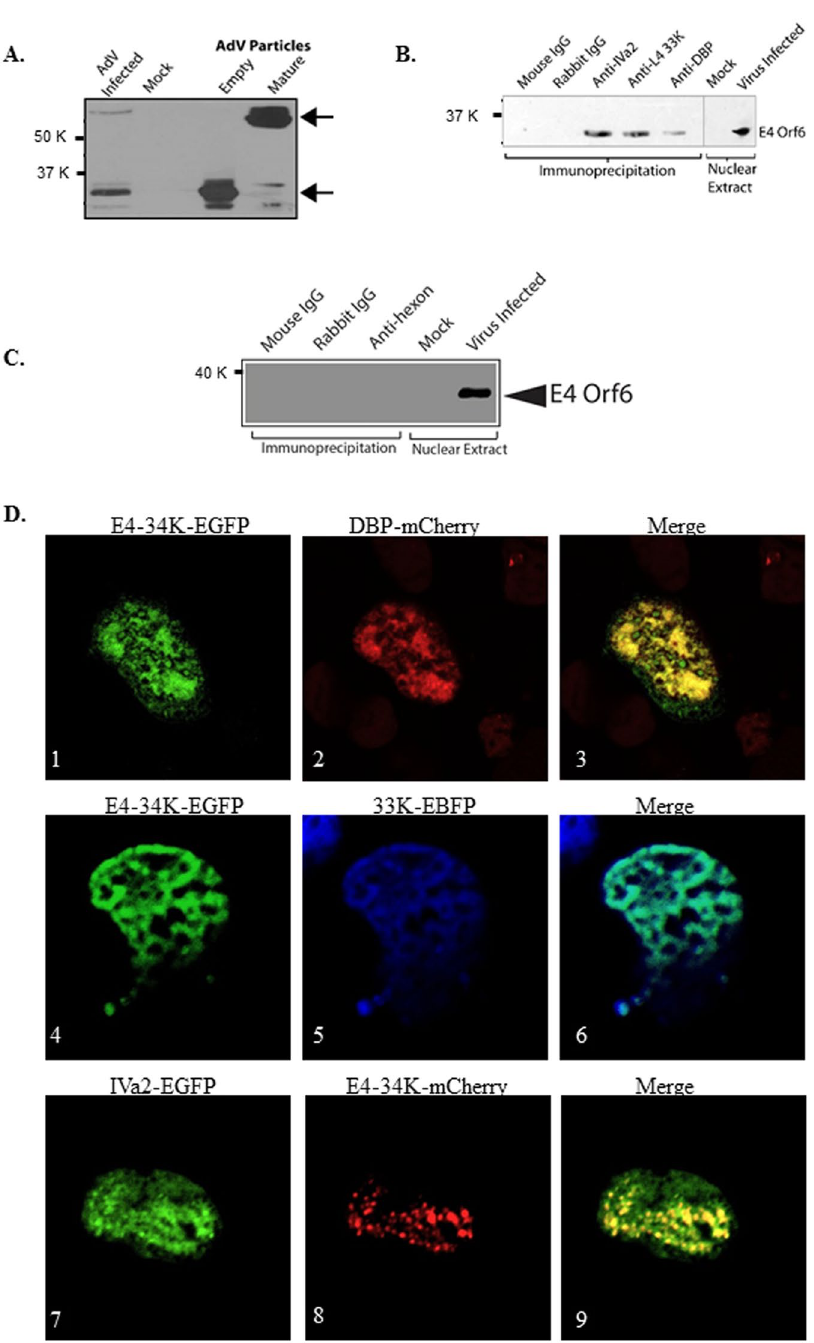
Figure 2. Interaction of E4 34K with AdV packaging proteins. ( A ) Presence of E4 34K in empty and mature AdV particles. Lysates of 10 µ g of purified empty or mature particles of HAdV-C5 were separated by SDS–PAGE for immunoblot with anti-E4 34K antibody. The bands corresponding to monomer and dimer of E4 34K are indicated. ( B) Co-immunoprecipitation of E4 34K with IVa2, 33K and DBP. Nuclear extracts of HAdV-C5 infected cells were immunoprecipitated with anti-IVa2, anti-33K or anti-DBP antibodies, normal mouse IgG or normal rabbit IgG. Immunoprecipitated proteins and total proteins from nuclear extracts of mock-infected and infected cells were separated by SDS-PAGE for immunoblot analysis with anti-E4 34K antibody. ( C) Nuclear extracts of HAdV-C5 infected cells were immunoprecipitated with anti-hexon antibody, normal mouse IgG or normal rabbit IgG. Immunoprecipitated proteins and total proteins from nuclear extracts of mock-infected and infected cells were separated by SDS-PAGE for immunoblot analysis with anti-E4 34K antibody. ( D) Co- localization of E4 34K with IVa2, 33K and DBP in 293 cells. 293 cells were transfected with plasmids expressing E4 34K-EGFP and DBP-mCherry (panels 1–3), E4 34K-EGFP and 33K-EBFP (panels 4–6) or IVa2-EGFP and E4 34K-mCherry (panels 7–9) fusion proteins. Cells were analyzed by confocal microscopy 36 h post- transfection. The images were taken at 60 × magnification. The images are shown after 5 ×